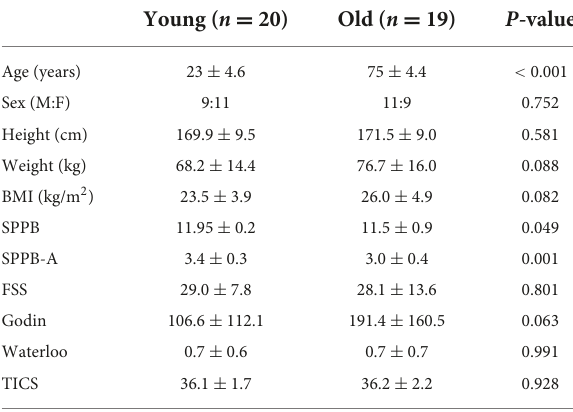
TABLE 1 Participant